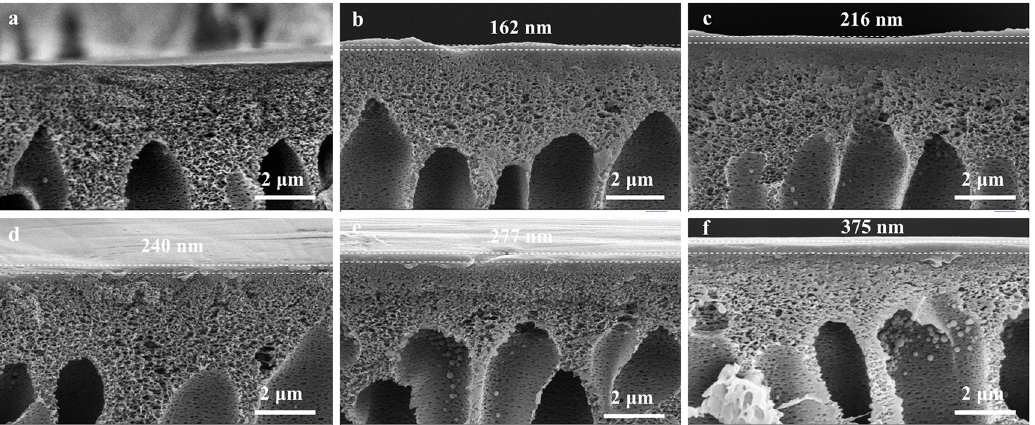
Figure 4. Cross-section morphologies images of loose TFC NF membranes and PES membranes by FESEM: ( a ) PES; ( b ) PES–DPS–0.5; ( c ) PES–DPS–0.75; ( d ) PES–DPS–1; ( e ) PES–DPS–2; and ( f ) PES–DPS–3 (Dashed lines are intended to facilitate observing the thickness of the PA layer).